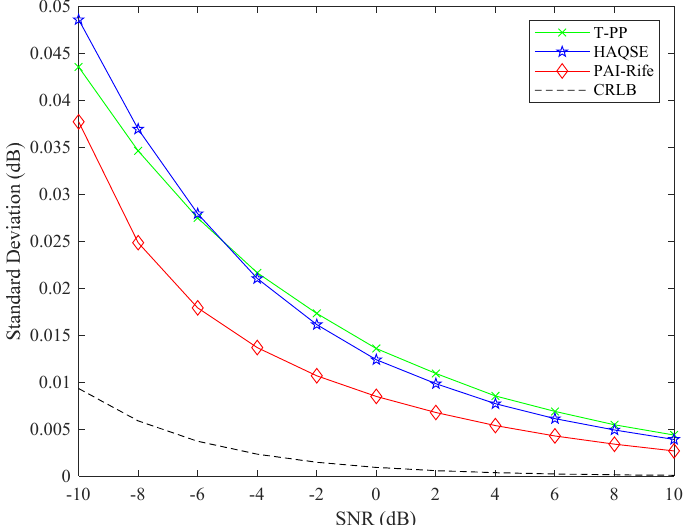
Figure 9. Standard deviation of PAI − Rife and other frequency − domain estimation algorithms at different SNRs.